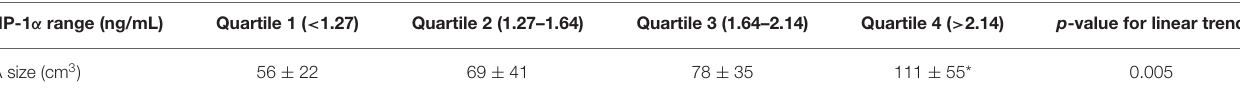
TABLE 4 | Left atrial volume according to quartile distribution on the basis of MIP-1 α level. MIP-1 α range